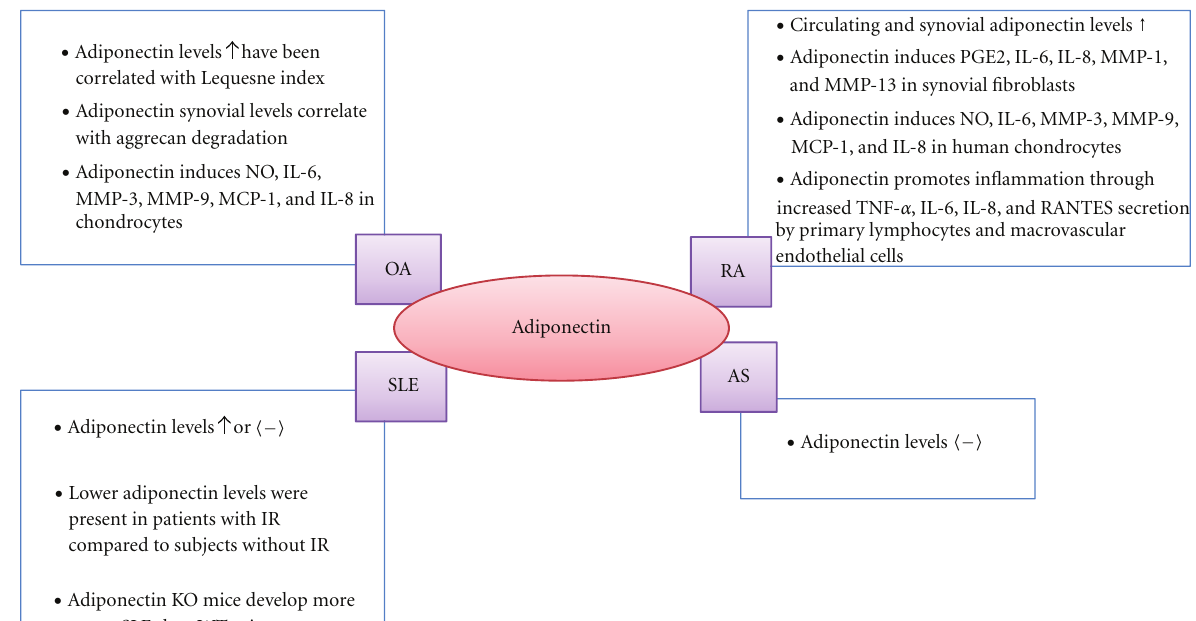
Figure 3: Schematic representation of adiponectin implication in several rheumatic